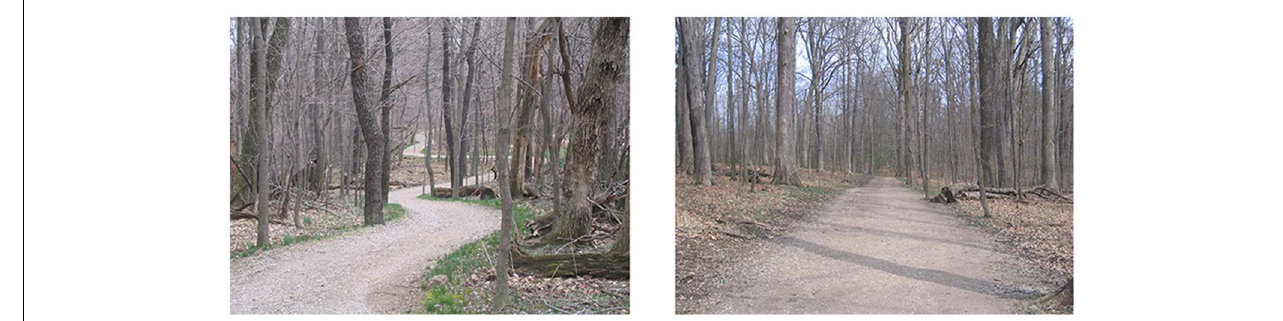
FIGURE 2 | Example of a high mystery (left) and low mystery (right) image.